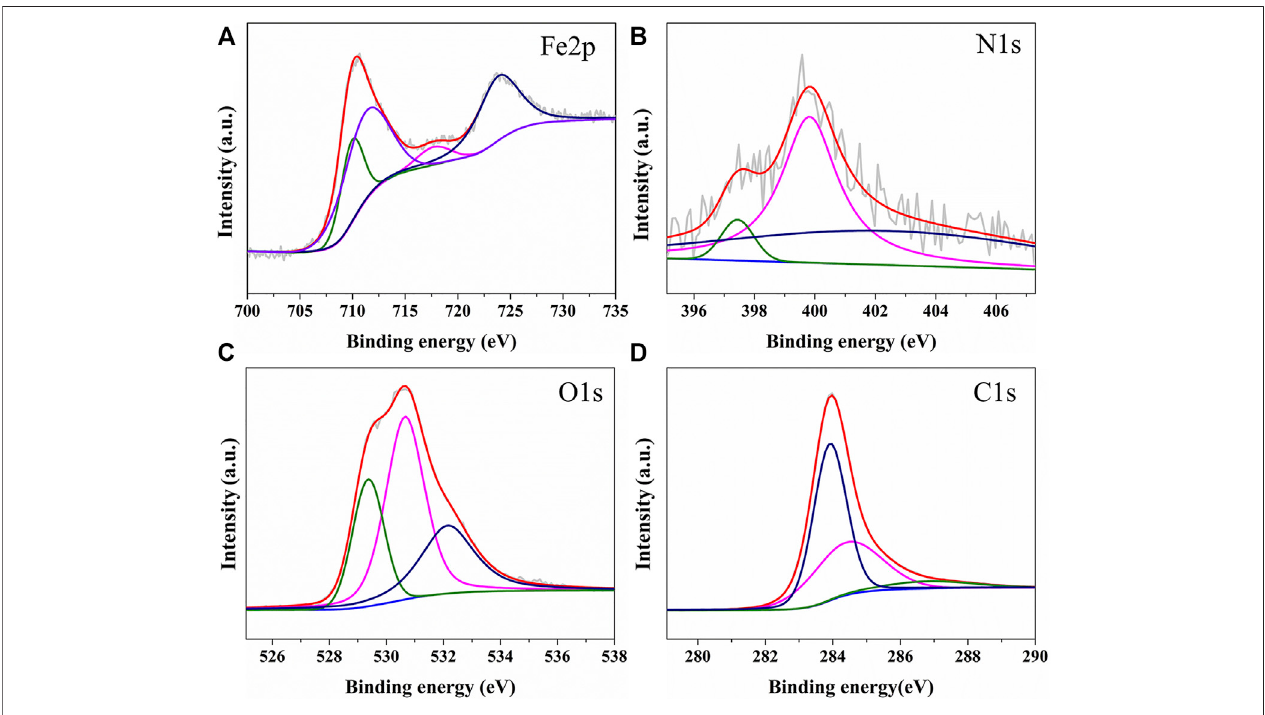
FIGURE 4 | XPS of Fe-EMC. (A) Fe2p; (B) N1s; (C) O1s; (D) C1s.